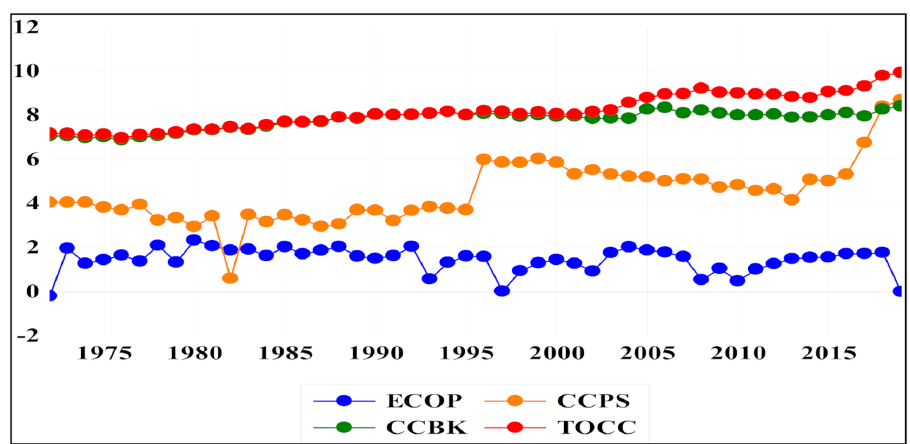
Figure 1. Graphical display of